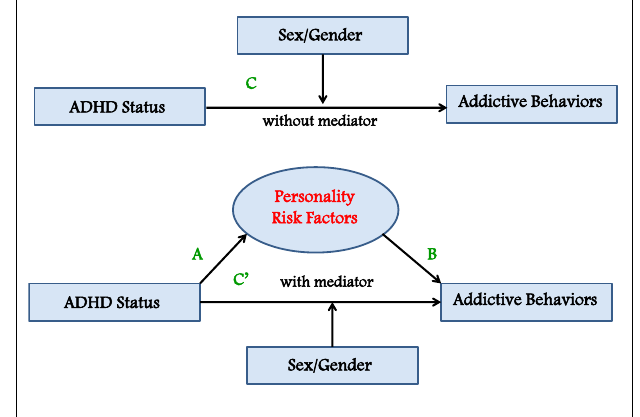
FIGURE 1 | Moderated-mediation model predicting that a personality-risk index mediates the relationship betweenADHD status and a composite measure of addictive behaviors, and that sex moderates these associations